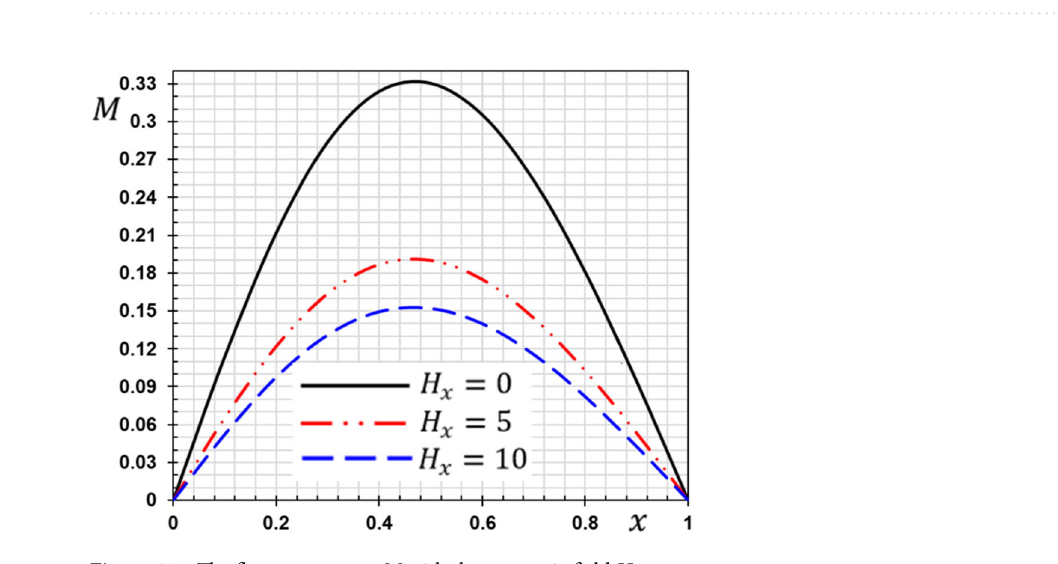
Figure 16. The displacement u with the magnetic field H x .